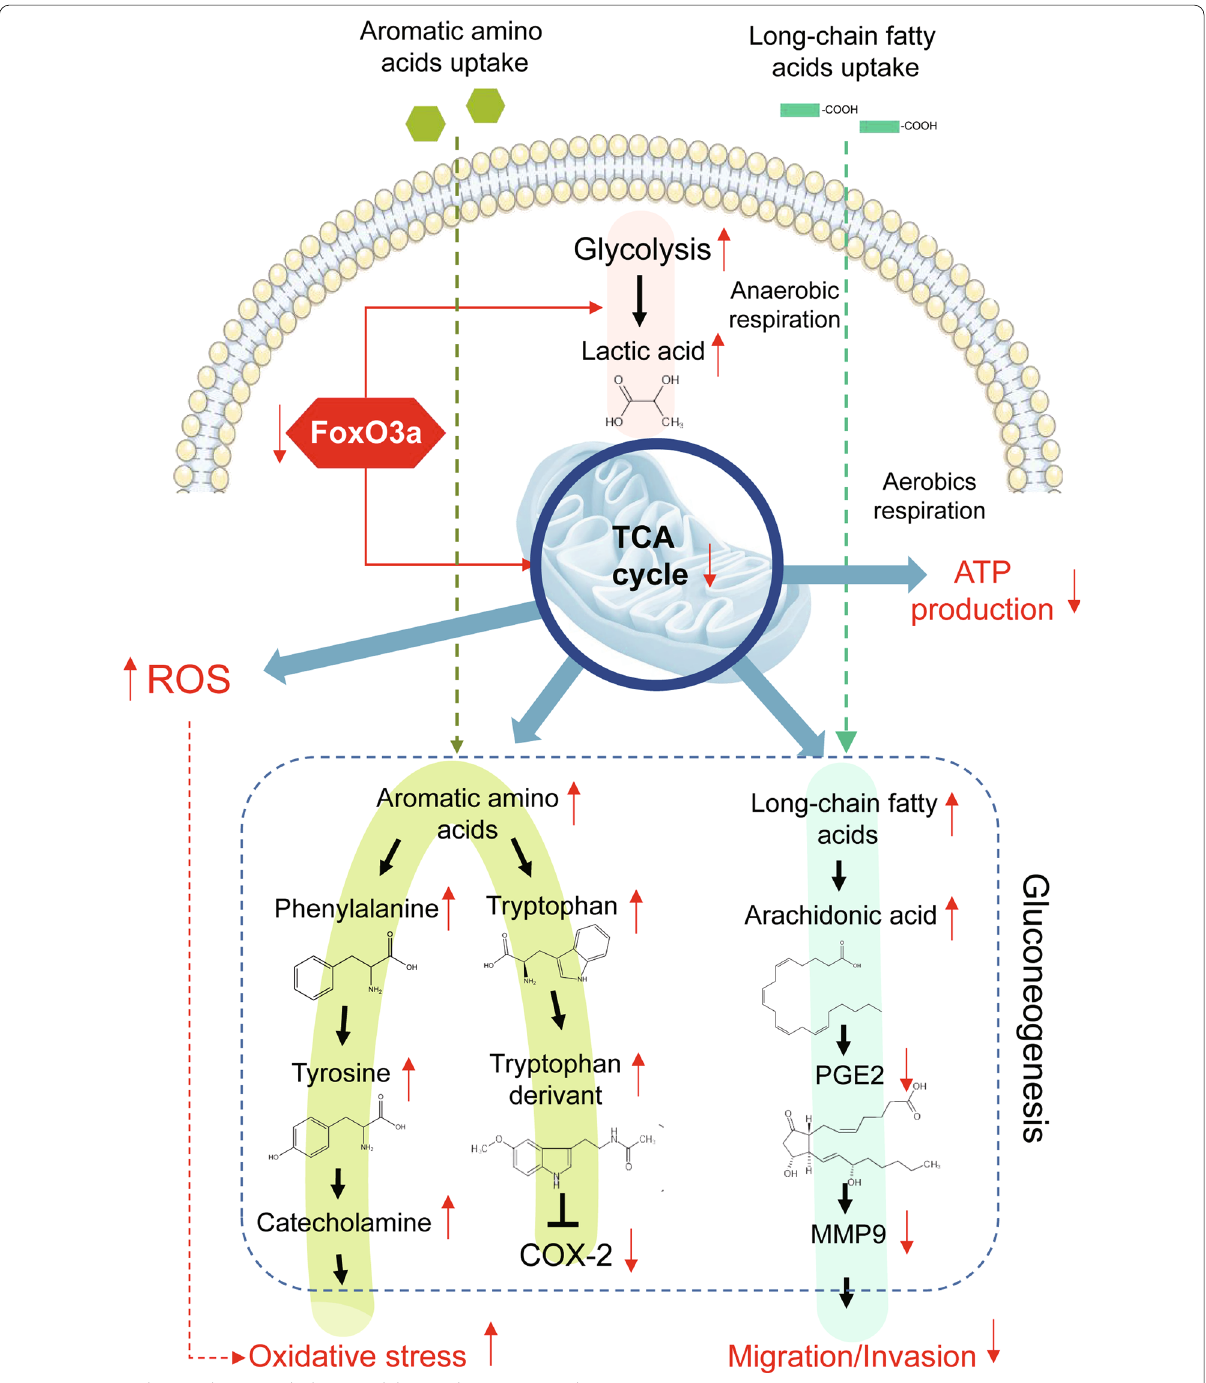
Fig. 7 FoxO3a plays a role in metabolic remodeling and transcriptional